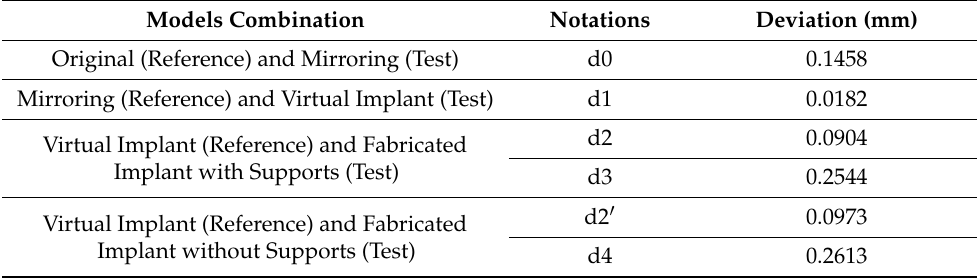
Table 3. Outcome of 3D deviation